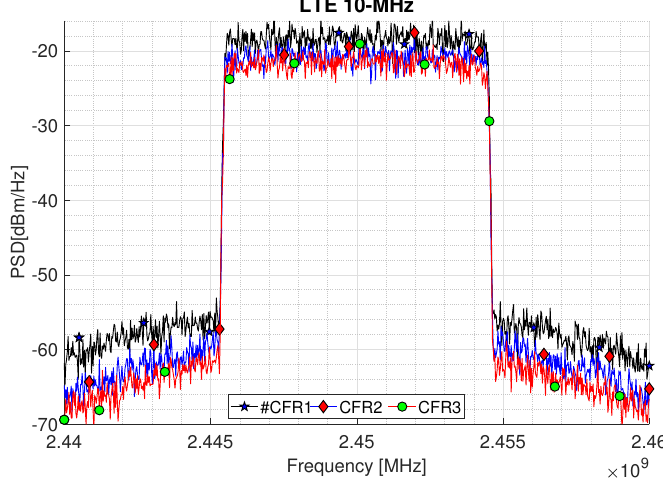
Figure 9. PSD of LTE 10–MHz OFDM waveform signal with residual spectral regrowth after CFR using three scale